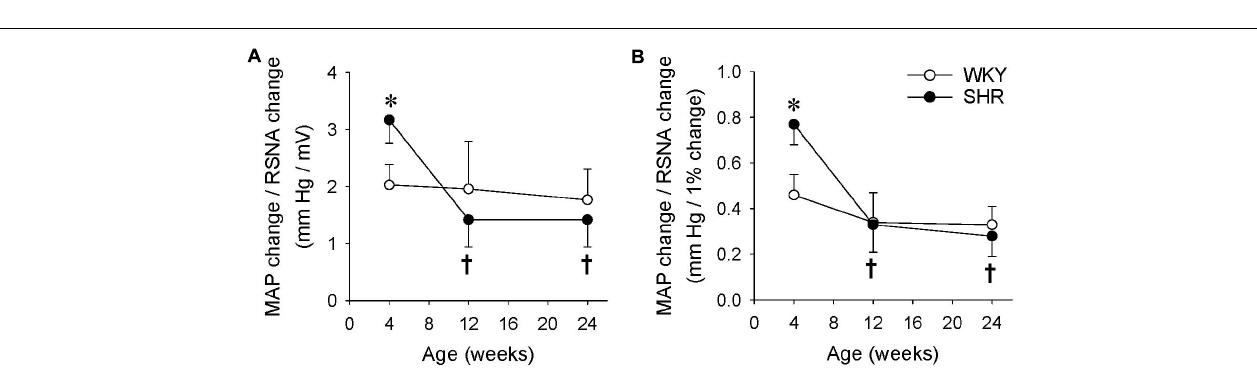
FIGURE 5 | Difference of the RSNA and MAP responses to renal infusion of capsaicin in the WKY and SHR at the ages of 4, 12, and 24 weeks. The ERR was induced by renal infusion of capsaicin at 1 nmol/min for 20 min. (A) The ratio of MAP change to RSNA change induced by capsaicin. The values were expressed as mmHg/mV. (B) The ratio of MAP change to RSNA change induced by capsaicin. The values were expressed as mm Hg/1% RSNA change. Values are mean ± SE. ∗ P < 0.05 vs WKY. † P < 0.05 vs 4 weeks. n =